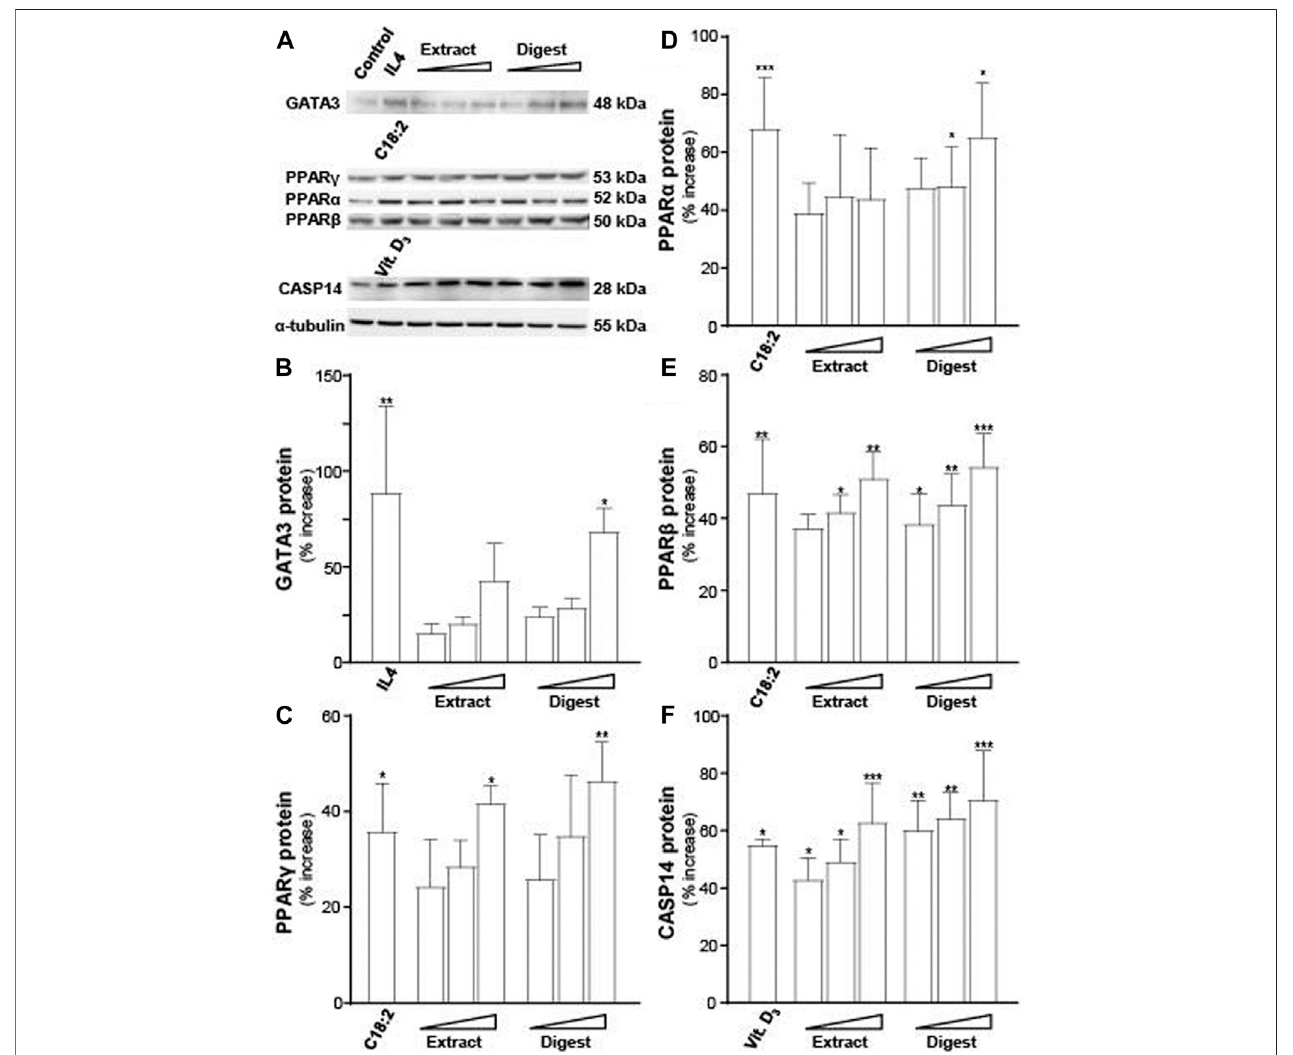
FIGURE 7 | EBN induces the expressions of targeted proteins corresponding to moisturize skin. (A) Western blot membranes showing GATA3, PPARs, and CASP14proteinexpressionsafter24-htreatmentsofEBNextractanddigestwereassessedindosesof1,10,100 μ g/mL(asindicated).IL-4at100 ng/mL,linoleicacid (C18:2) at 30 μ M and cholecalciferol (vitamin D 3 ) at 10 – 5 M were adopted as positive controls in GATA3, PPARs, and CASP14 expressions. The quanti fi cation of (B) GATA3, (C) PPAR γ , (D) PPAR α , (E) PPAR β , and (F) CASP14 are shown. The expression levels, in relative to α -tubulin protein, are expressed as the percentage of increasetonormalizedbasalexpressionsetat0inmean ± SEM, n (cid:2) 3.Statisticallysigni fi cantresultsaremarkedwith* p < 0.05,** p < 0.01,and*** p < 0.001againstthe control.